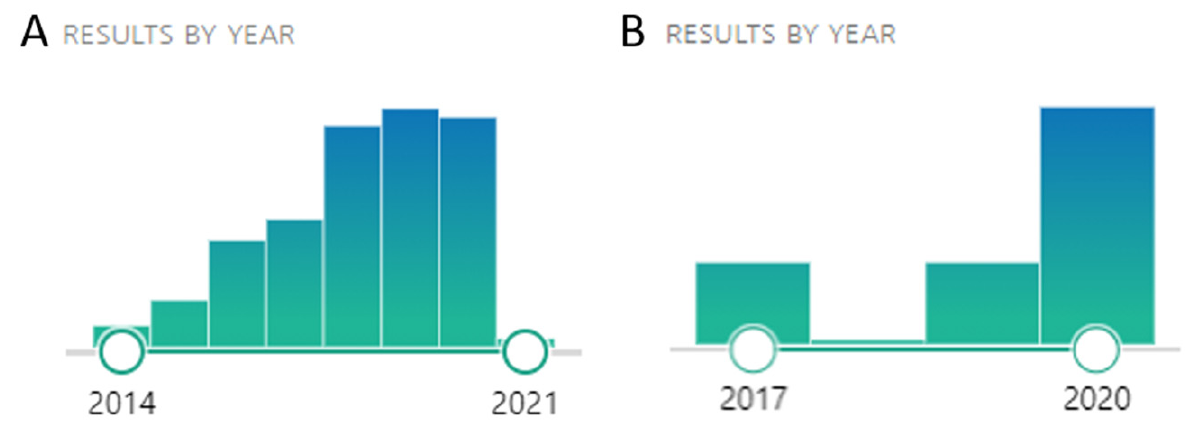
Figure 3. ( A ) Number of articles on PubMed using the keywords “ S. cerevisiae ” and “CRISPR/Cas9,” from 2014 to 2021. Data retrieved from https://pubmed.ncbi.nlm.nih.gov/?term=S.+cerevisiae+CRISPR%2FCas9&sort=pubdate. ( B ) Number of articles on PubMed using the keywords “wine yeast” and “CRISPR/Cas9”. Data retrieved from https://pubmed.ncbi.nlm.nih.gov/?term=wine+yeasts+CRISPR%2Fcas9&filter=simsearch1.fha&sort=pubdate. Accessed 22 Novem-